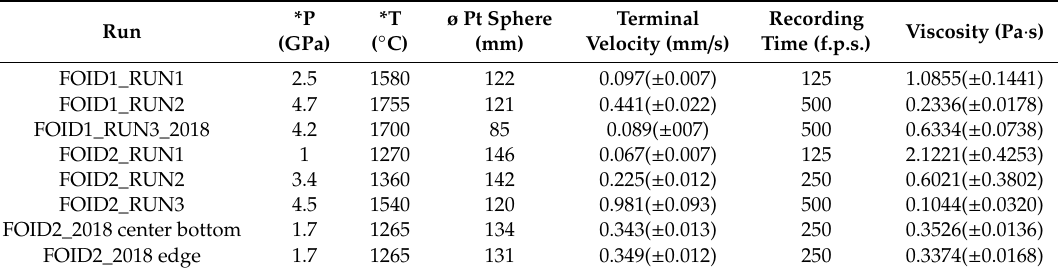
Table 2. Experimental conditions and